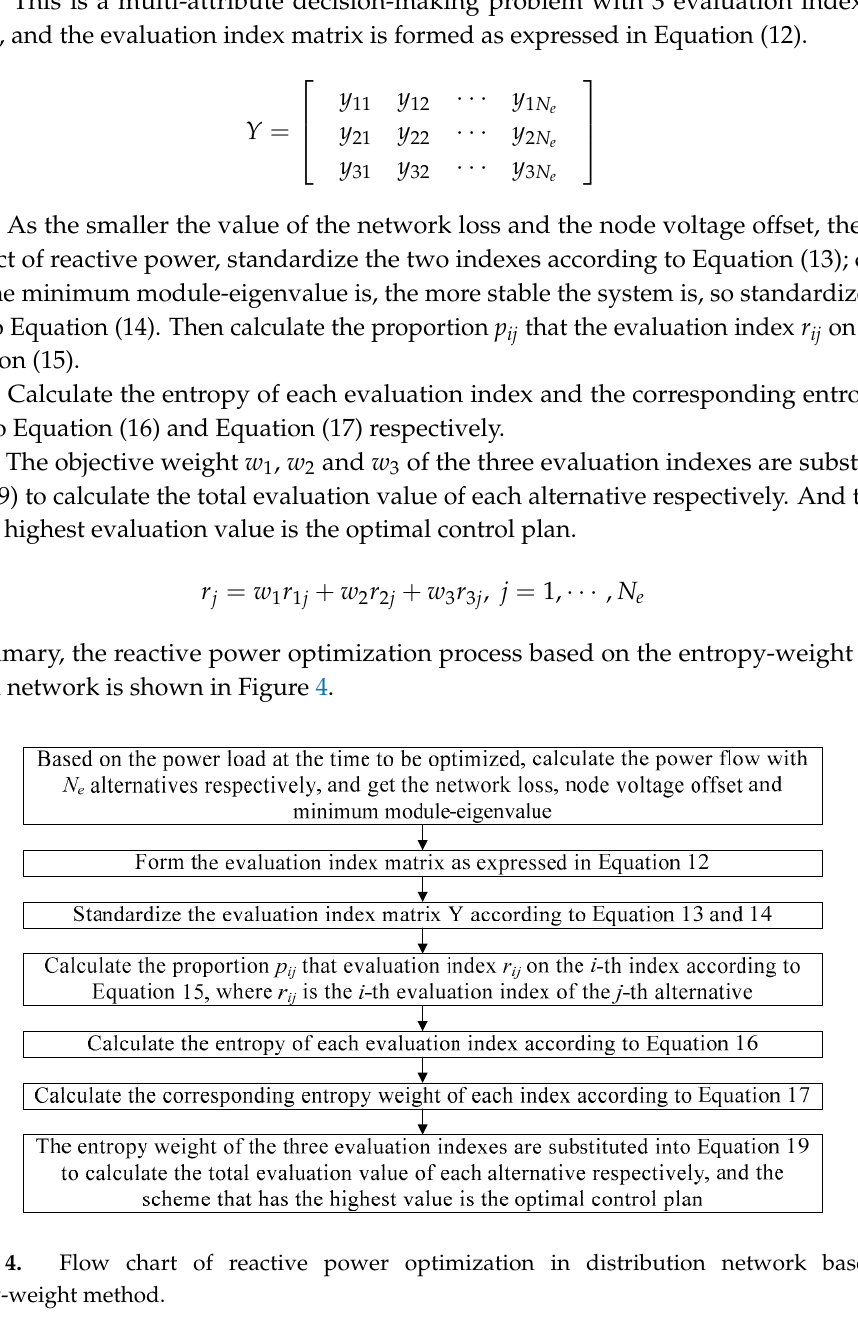
Algorithm (GA) method, neighborhood search method and Sequential Quadratic Programming (SQP) method, is proposed to ensure the optimality and practicability. For example, the